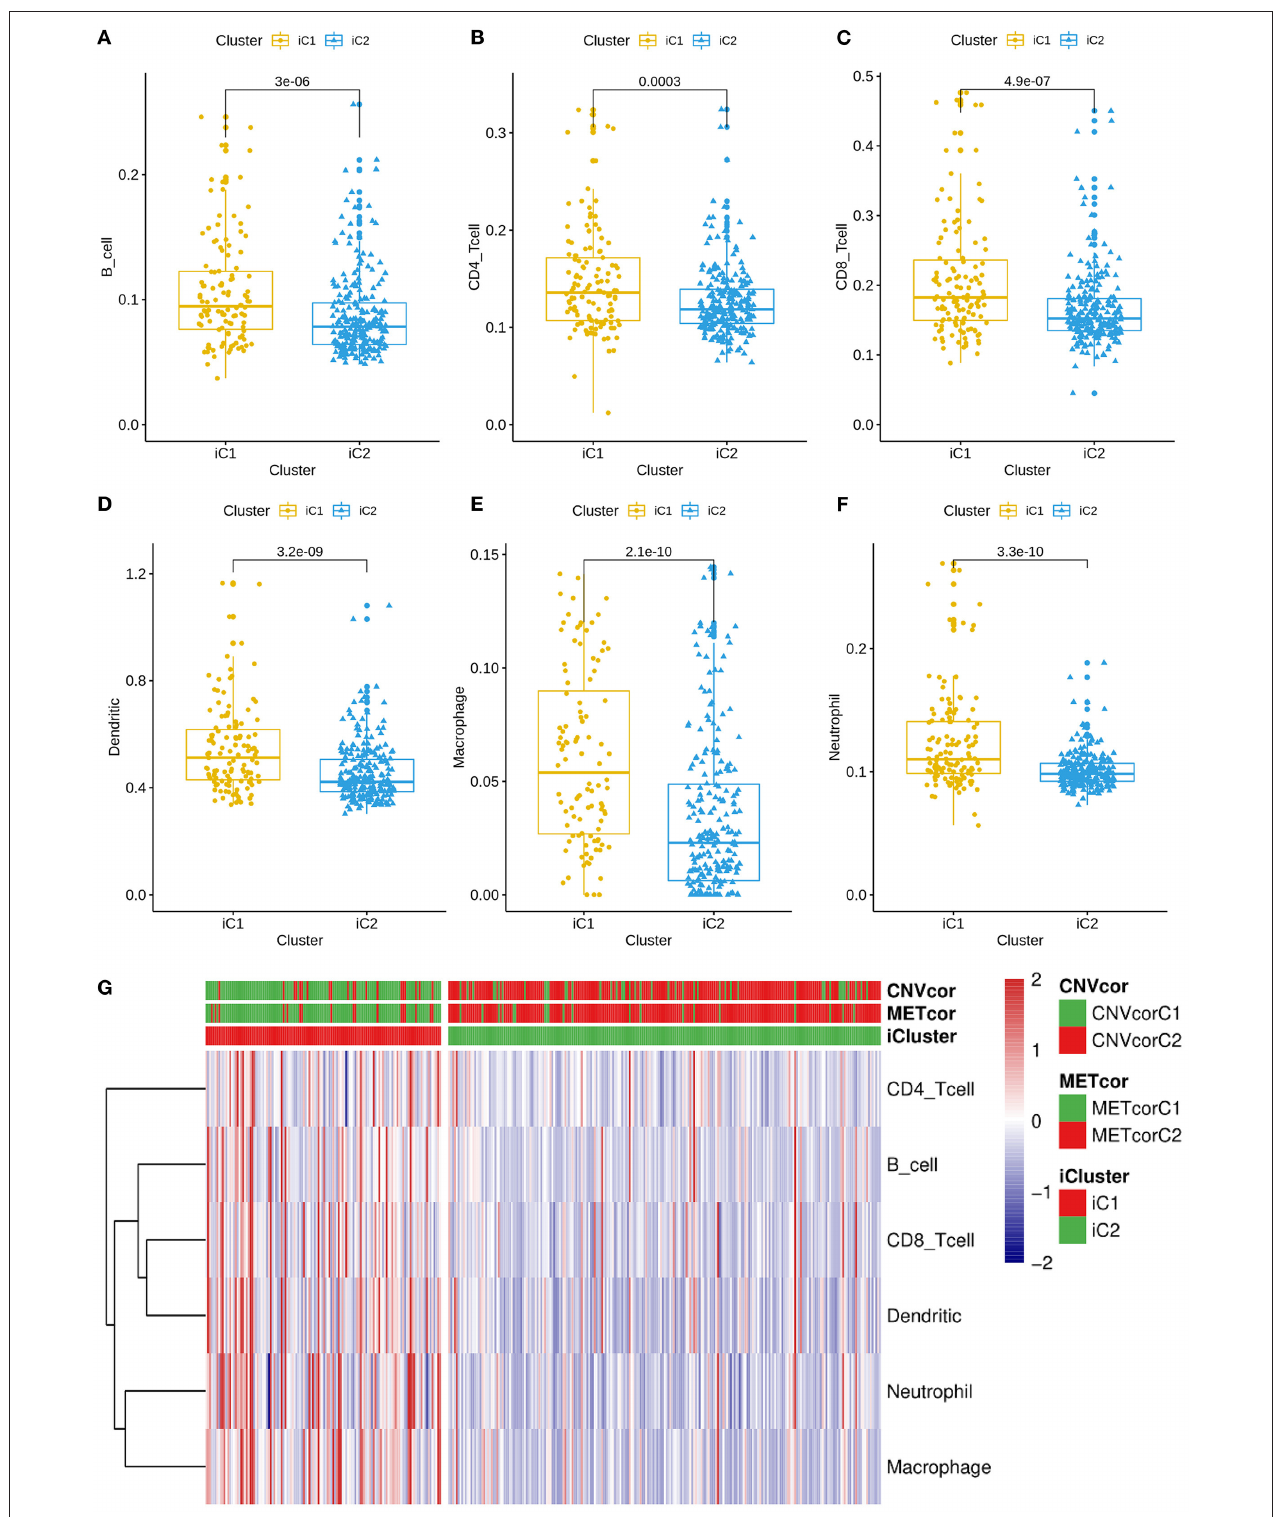
FIGURE 5 | Differences in immune infiltrations between two multi-omics molecular subtypes for liver cancer. Differences in contents of B cells (A) , CD4 + T cells (B) , CD8 + T cells (C) , dendritic cells (D) , macrophages (E), and neutrophils (F) between iC1 and iC2 subtypes. (G) Heatmap for six immune cell scores among all samples.